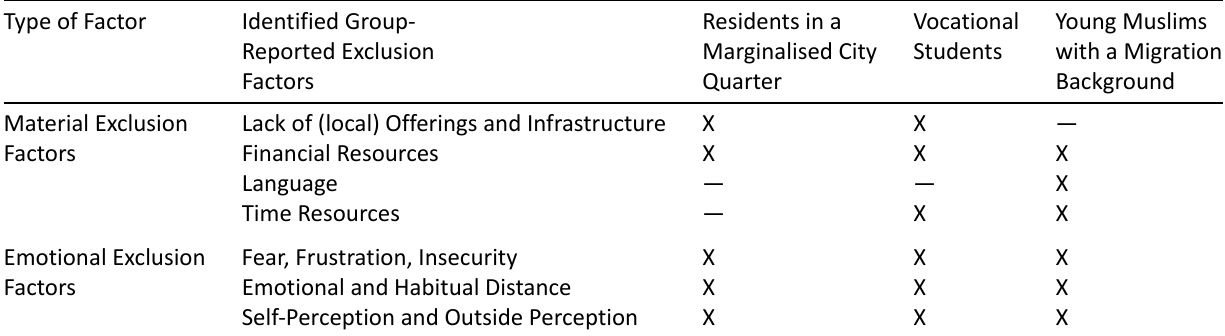
Table 2. Overview of the exclusion factors found in the